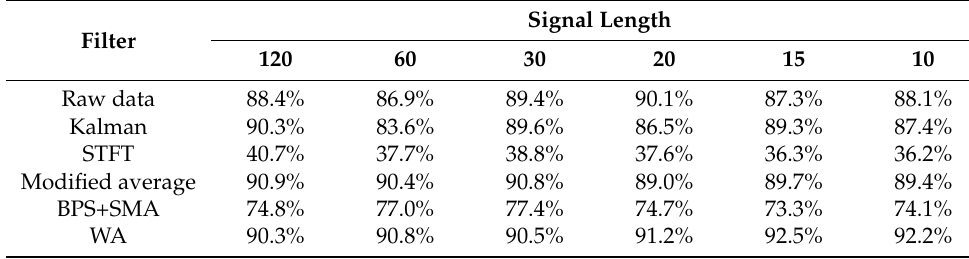
Table 4. Accuracy of MobileNet for filtered PPG